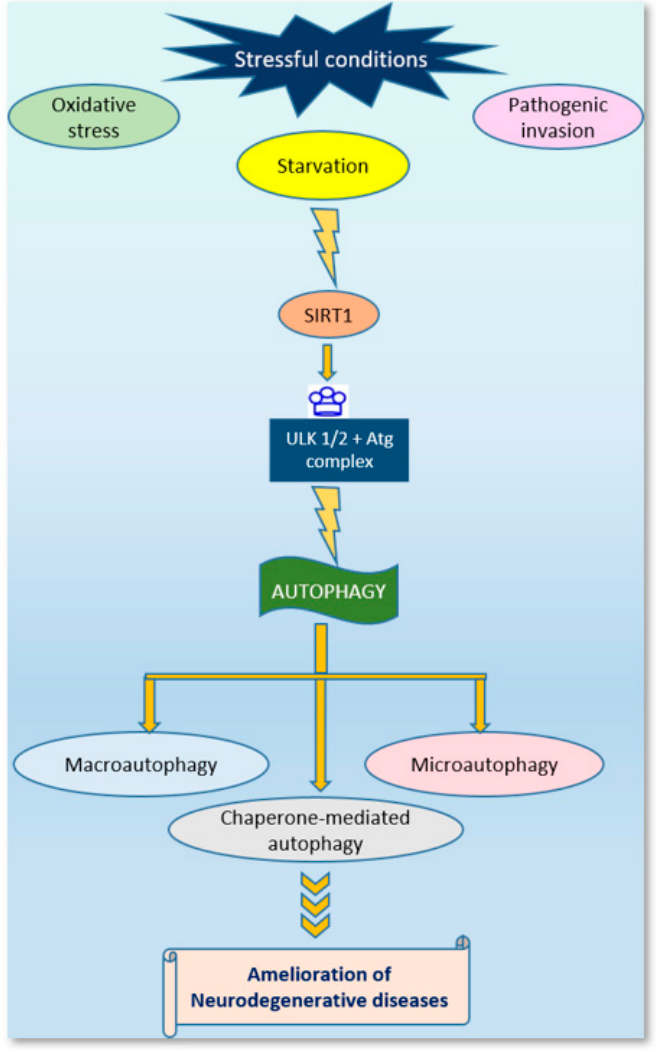
Figure 2. Schematic representation showing the involvement of SIRT1 in promoting autophagy and ameliorating neurodegeneration.